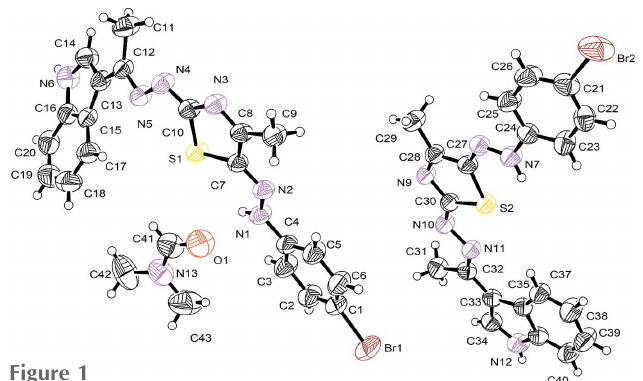
Figure 1 An ORTEP representation of the asymmetric unit showing 50% probability